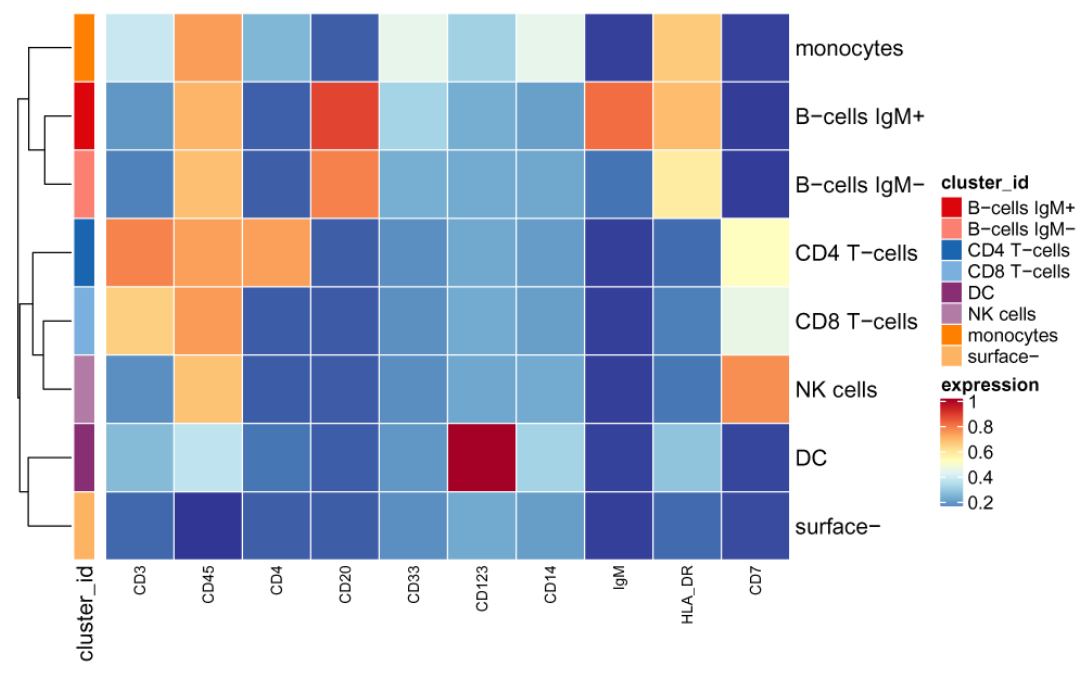
Figure 17. Heatmap of the median marker intensities of the 10 lineage markers in the 8 PBMC cell populations obtained by manual merging of the 20 metaclusters generated by FlowSOM. As in Figure 6, the heat represents the median of arcsinh and 0-1 transformed marker expression calculated over cells from all the samples. The dendrogram on the left represents the hierarchical similarity between the 8 populations calculated using Euclidean distance and average linkage.